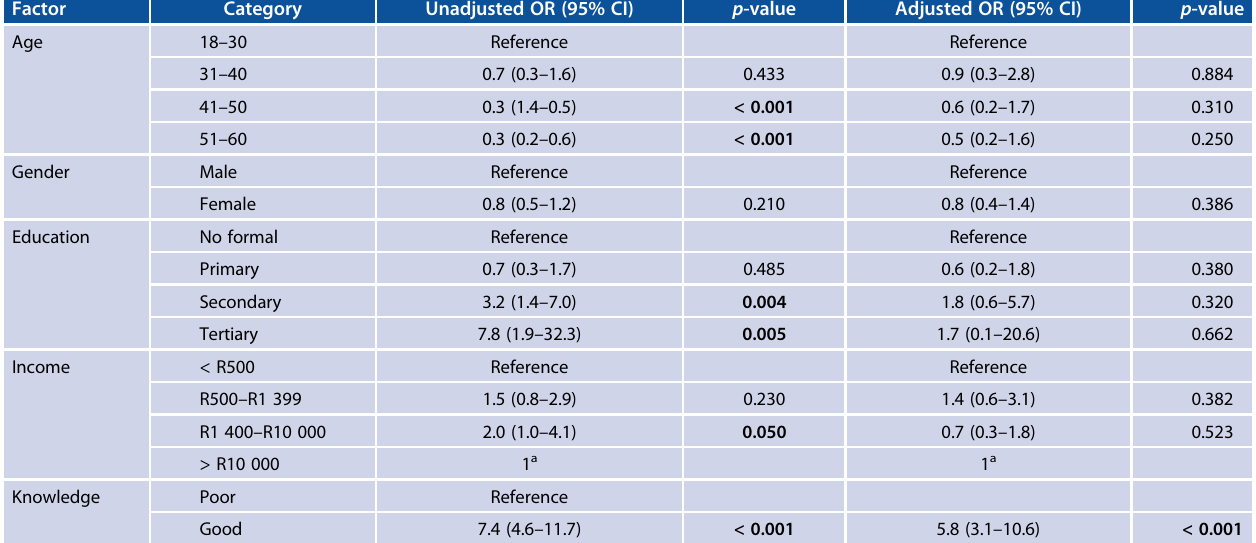
Table 7: Sociodemographic characteristics associated with good practices regarding antibiotic use amongst patients at Prince Mshiyeni Memorial Hospital 2017